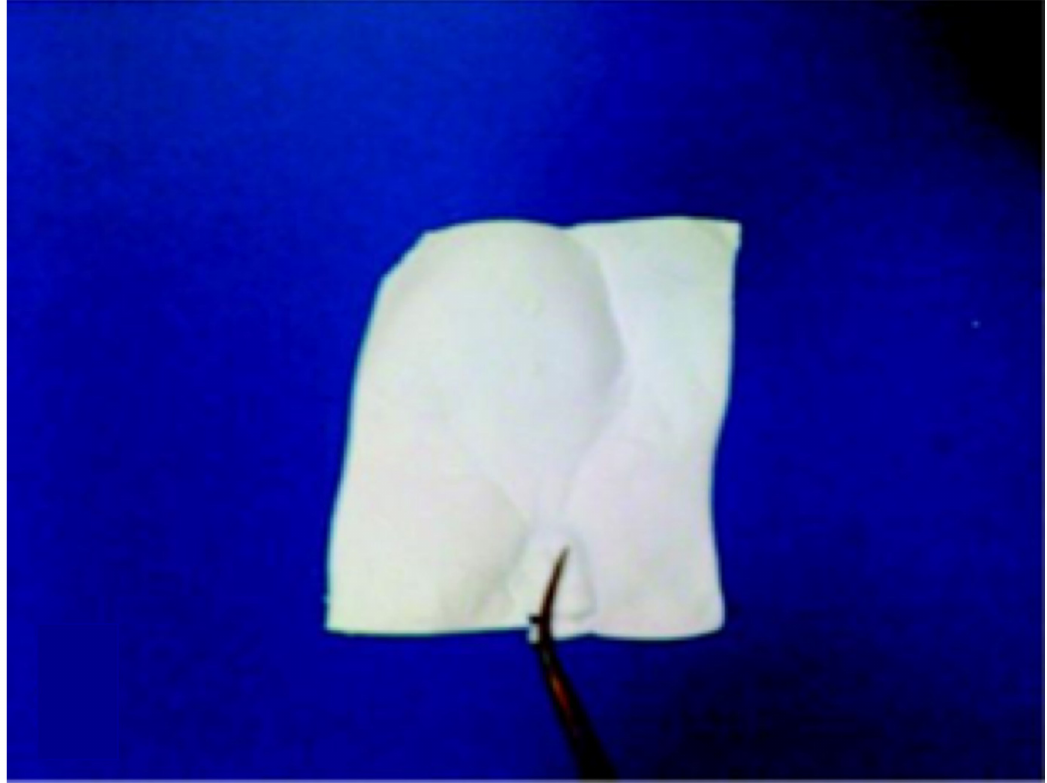
Figure 9. Electrospun PSBMA for non-adherent, superabsorbent, and antimicrobial wound dressing applications. Reprinted with permission from ref. [217]. Copyright 2012